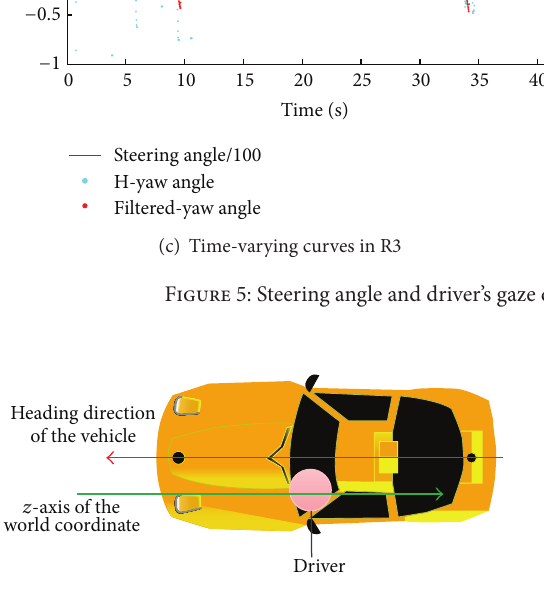
Figure 6: Vehicle’s true heading.